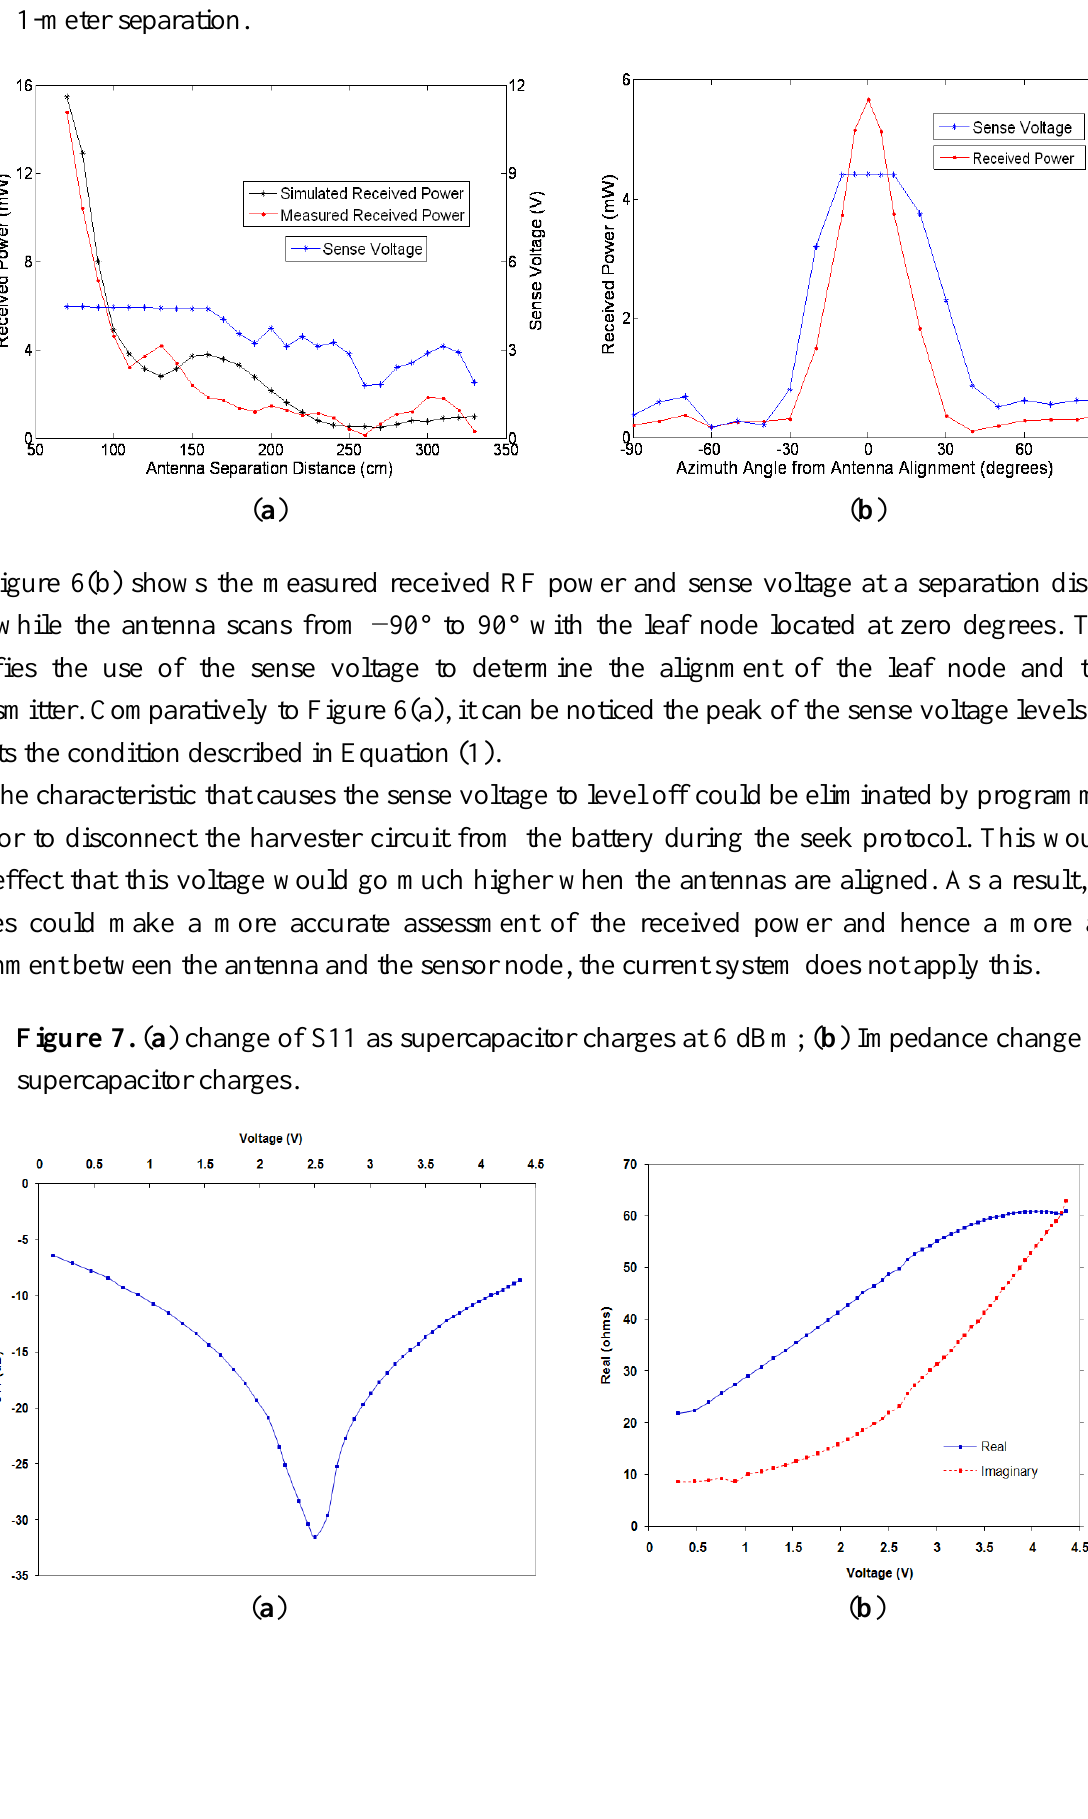
Figure 6. ( a ) Received power and sense voltage as separation distance increases; ( b ) Plot of received power and sense voltage at different azimuth angles for antennas at 1-meter separation.